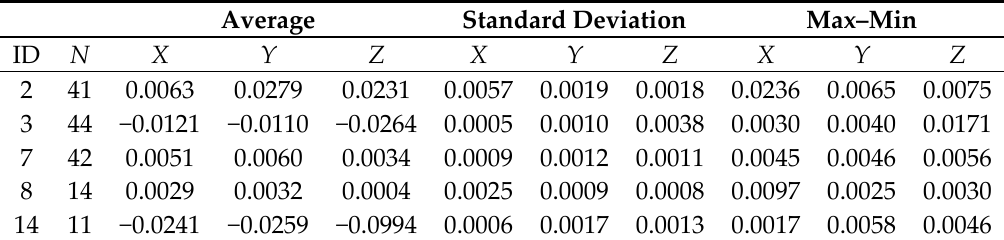
Table 2. Statistical parameters of smartphone accelerometer bias. Selected devices with more than 10 measurements are presented. Average and standard deviation [g 0 ] for the three axes are listed. Average